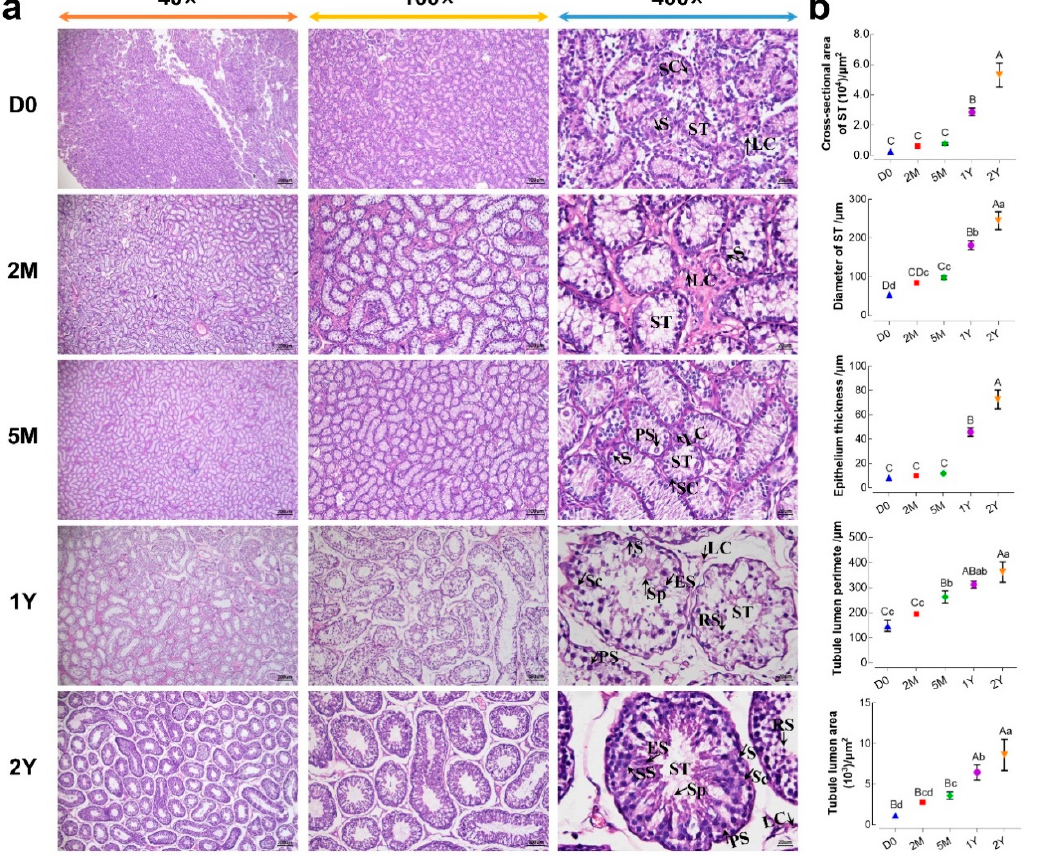
Figure 1. Morphological comparisons of testicular tissues at different development stages. ( a ) The representative images from D0, 2M, 5M, 1Y, and 2Y testicular cross sections at 40 × , 100 × , and 400 × magnification, respectively; ( b ) Values of the morphological parameters obtained from the seminiferous tubules at different ages: LC, Leydig cell; SC, Sertoli cell; ST, seminiferous tubule; S, spermatogonia; PS, primary spermatocyte; SS, secondary spermatocyte; RS, round spermatid; ES, elongated spermatid; Sp, spermatozoa. Data were presented as mean ± SD in the graphs. Different capital letters denote an extremely significant difference ( p < 0.01), while different lowercase letters denote a significant difference between groups ( p < 0.05). D0: 0 days old; 2M: 2 months old; 5M: 5 months old; 1Y: 1 year old; 2Y: 2 years old.